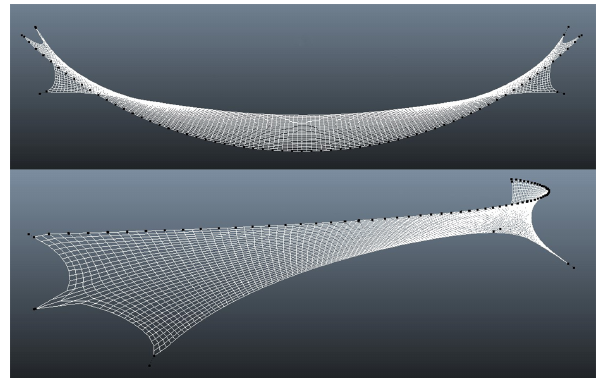
Figure 13: Form-finding of the shell of the curved shell-supported footbridge using a Particle Spring